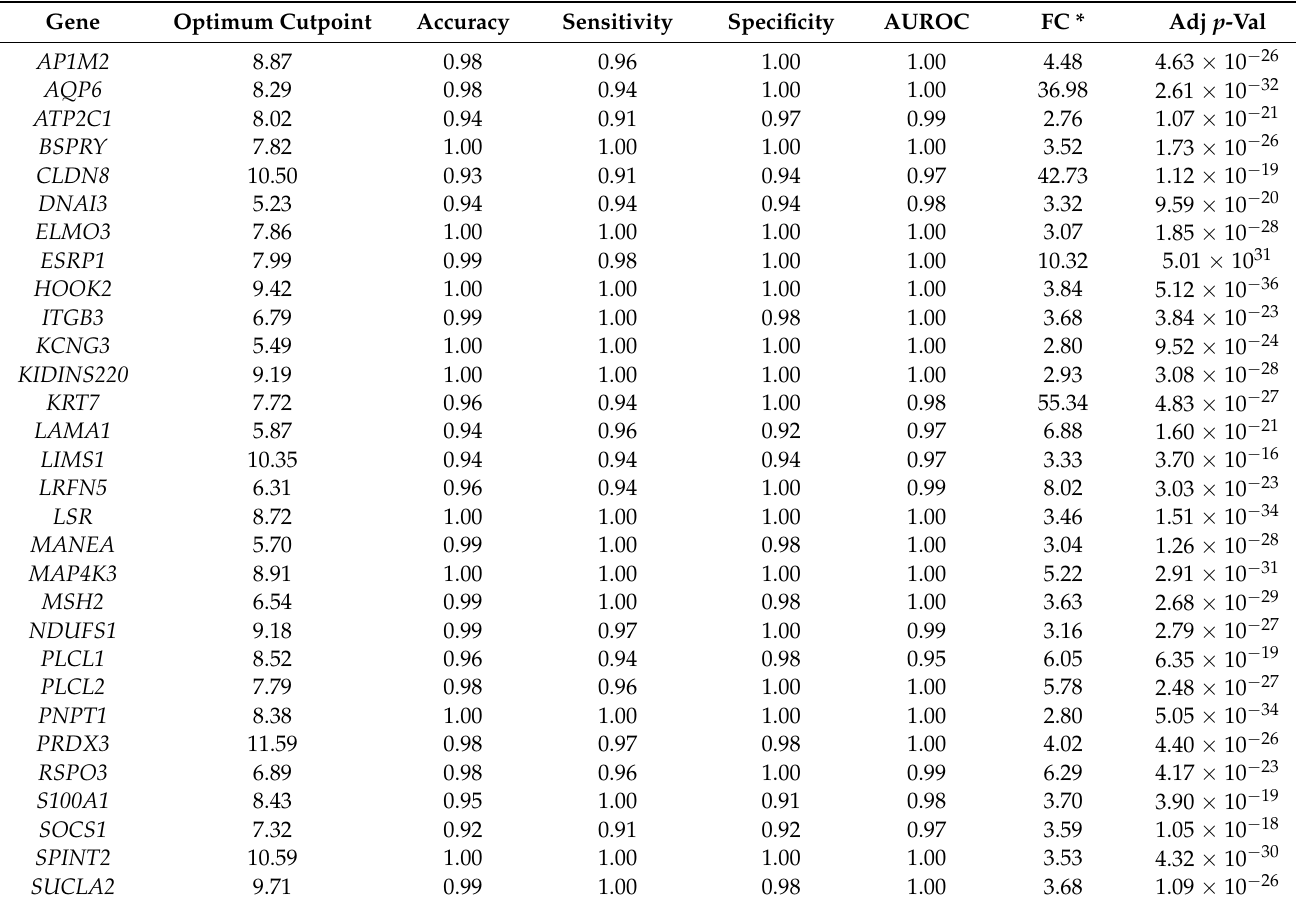
Table 2. List of thirty genes combined to create COGS signature for distinguishing chRCC from RO. Data presented is for discovery dataset to show sensitivity-specificity, accuracy, area under the receiver operator curve (AUROC) and log fold change (FC) for discovery